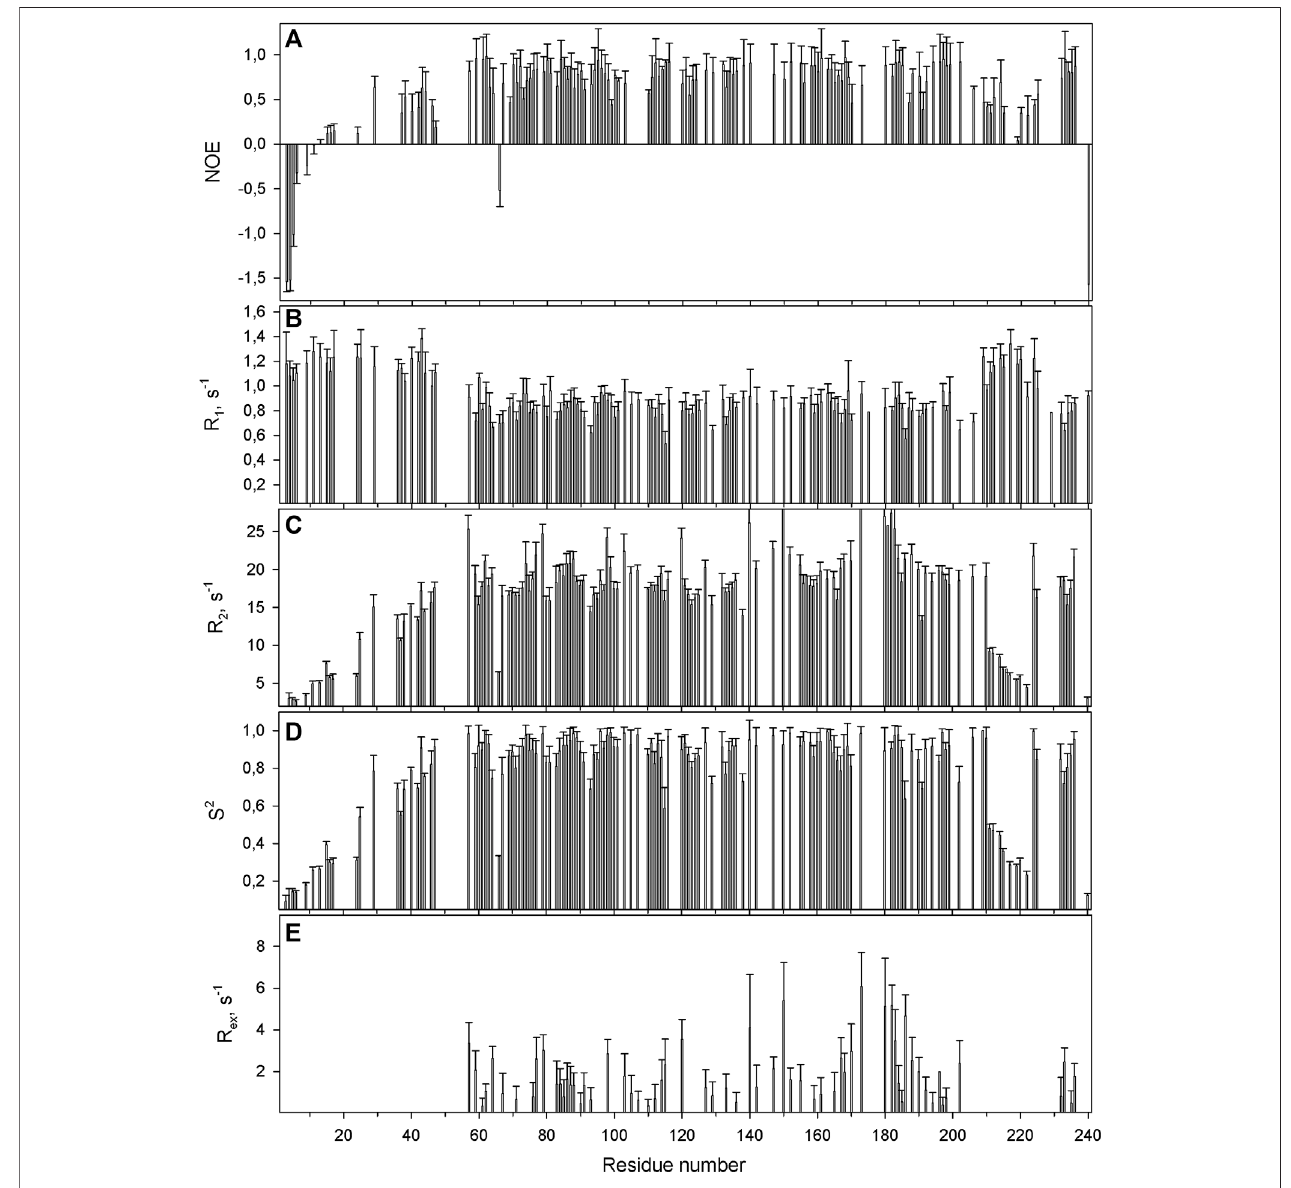
FIGURE 5 | The relaxation parameters of the amide 15 N nuclei of each residue of the apo-form of WBSCR27, measured at 16.3 T (700 MHz proton resonance frequency)and308 K. (A) Theheteronuclear 15 N, 1 H-steady-stateNOEvalues. (B) Thelongitudinalrelaxationrate R 1 (s − 1 ). (C) Thetransverserelaxationrate R 2 (s − 1 ). (D) The order parameter S 2 determined by model-free analysis. (E) Chemical exchange R ex contributions to the transverse relaxation rates (s − 1 ).